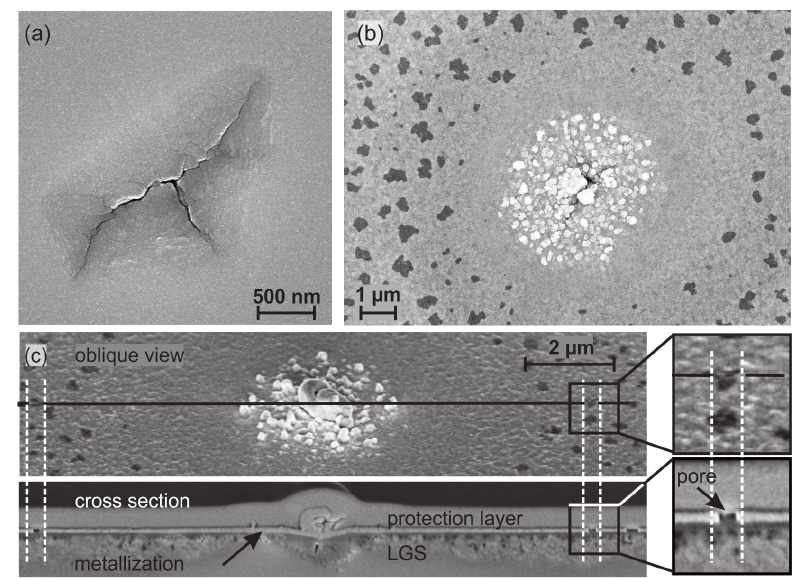
Figure 5. In-lens SEM image of a RuAl thin film deposited on a pretreated LGS substrate ( a ) before; and ( b ) after annealing at 800 ◦ C under high vacuum conditions at the position of a crack in the LGS (both images not showing the same sample position); ( c ) In-lens SEM image of such a feature taken in the FIB device together with an In-lens SEM image of a FIB cut through it.